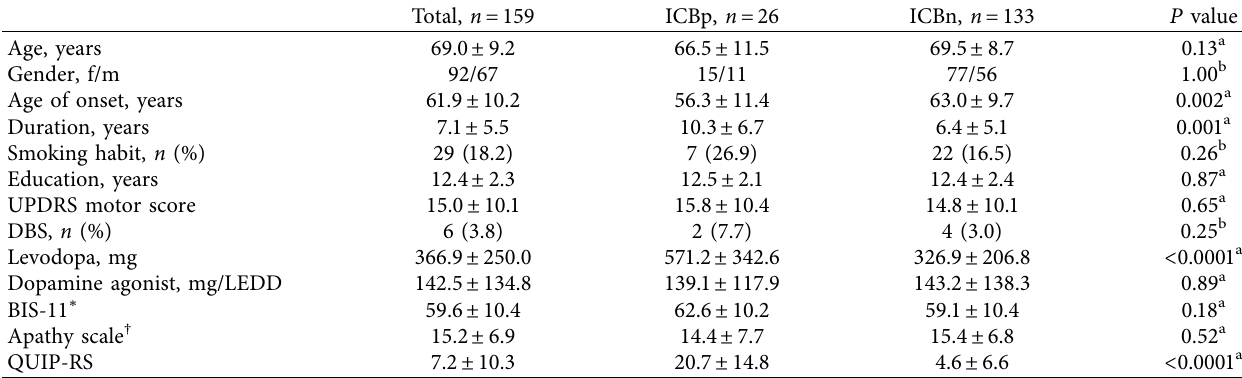
Table 1: Demographics and sample characteristics of patients with Parkinson’s disease.